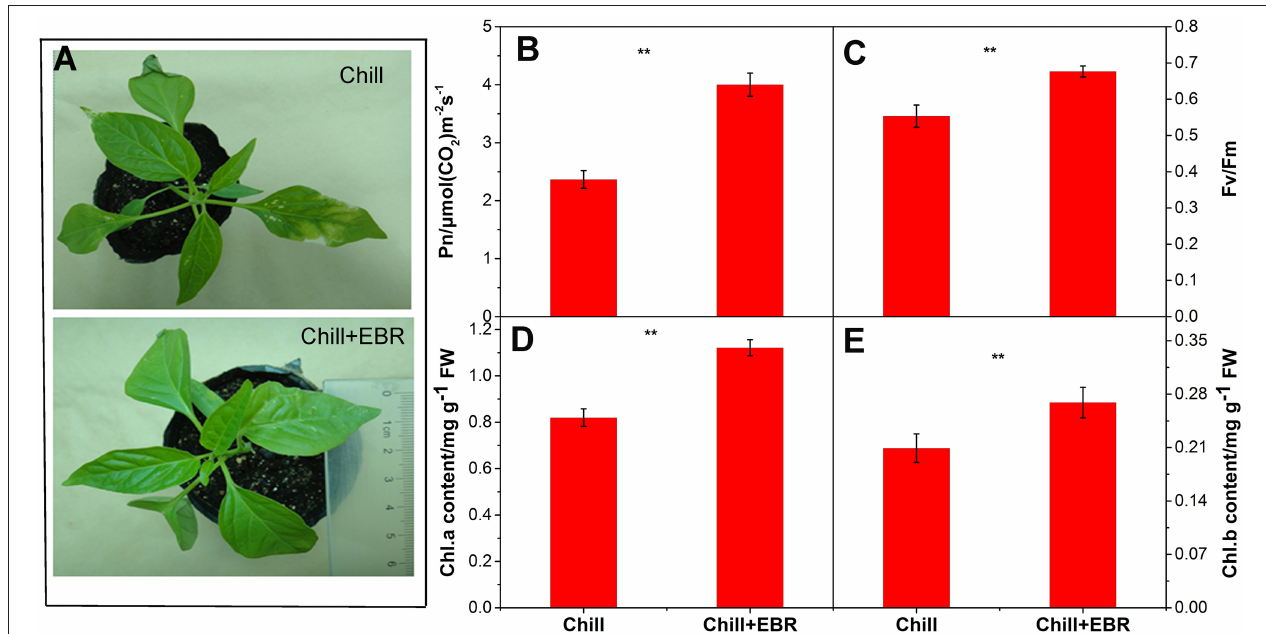
FIGURE 5 | Phenotypic changes (A), net photosynthetic rate (Pn) (B), Fv/Fm (C), chlorophyll a and chlorophyll b (D,E) in chill-stressed pepper seedlings with or without exogenous application of EBR. Asterisks above the histograms indicated significant differences between Chill and Chill + EBT by Student’s t- test (** P < 0.01; * P <